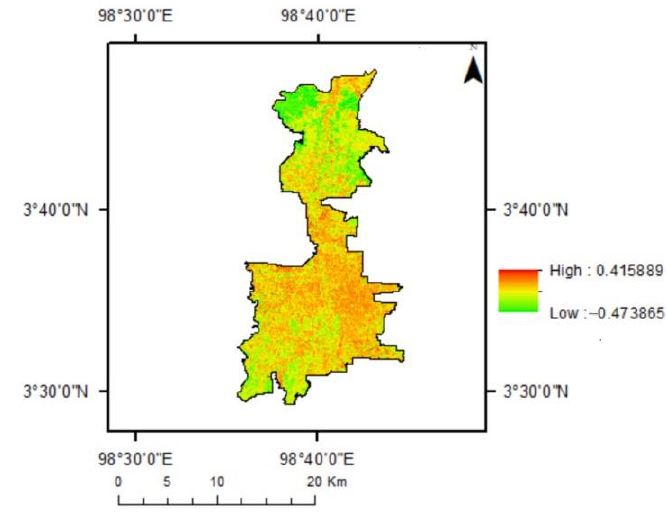
Figure 4. NDBI of Medan year 2019.